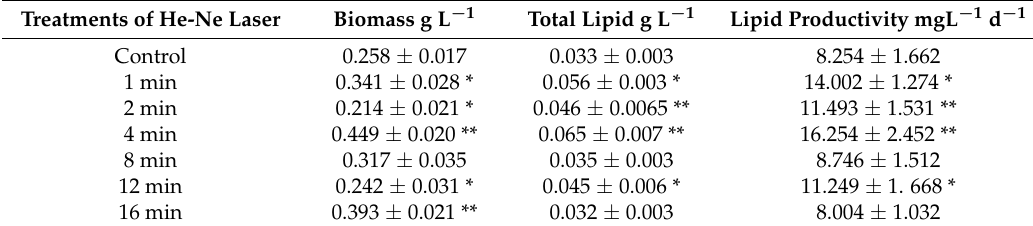
Table 2. Biomass concentrations, total lipid content, and lipid productivity of C. pacifica treated by He-Ne laser.